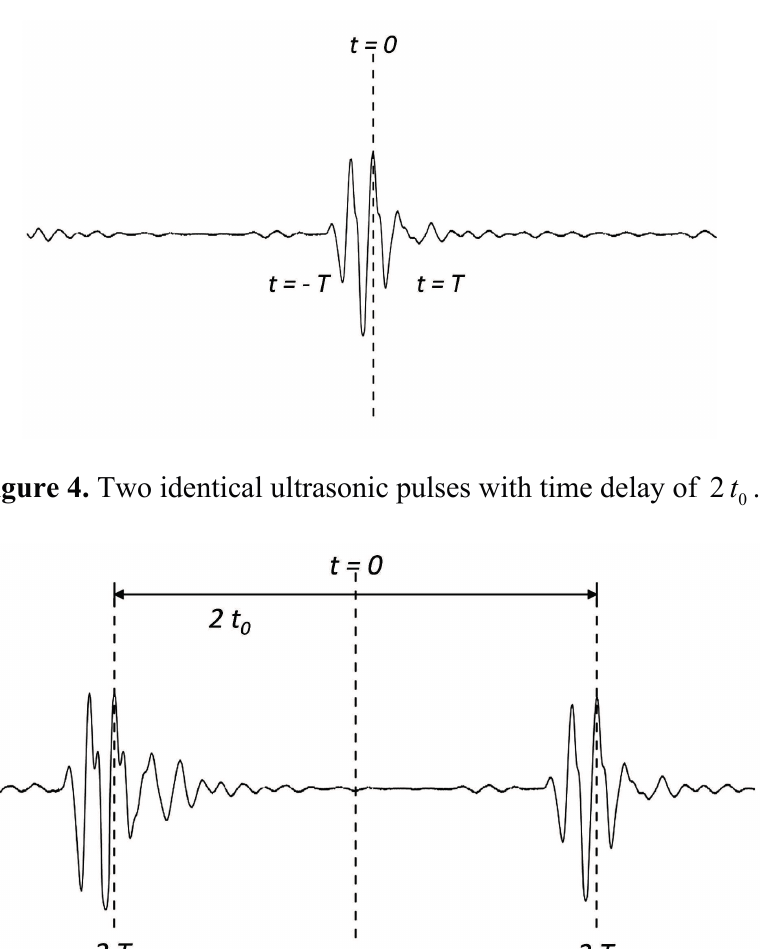
Figure 3. Ultrasonic pulse )( tf with duration of 2T.